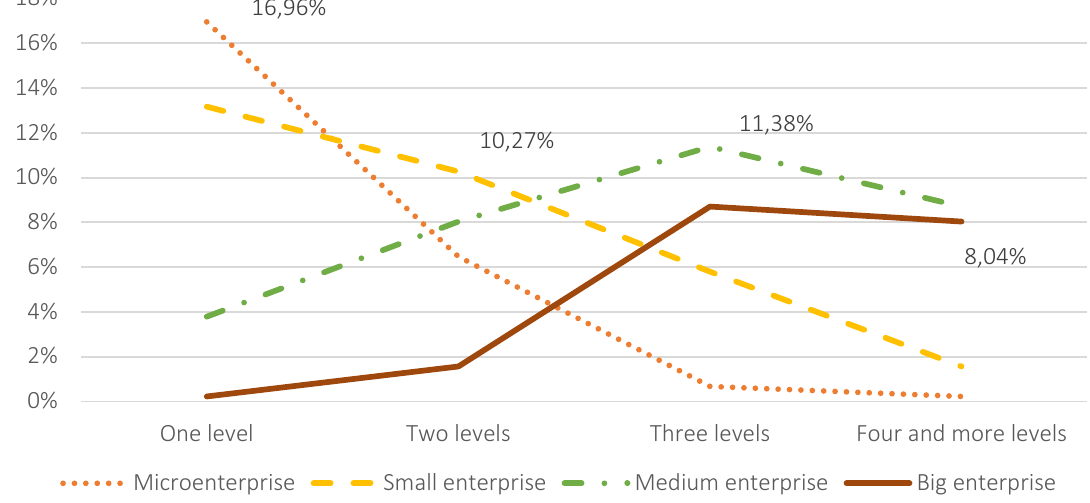
Figure 2. Percentage expression of dependence of the number of management levels on the size of an